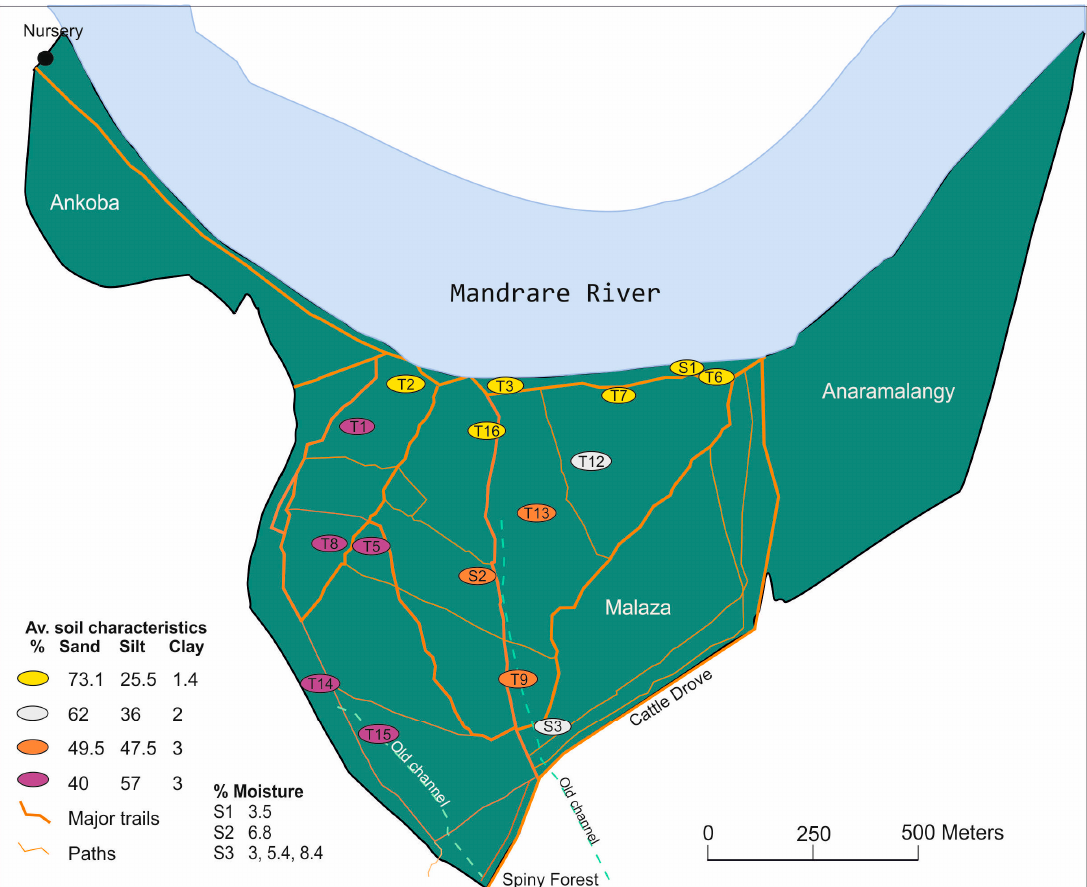
Figure 10. Soil sampling sites: The T samples are from the 2014 transects and the S1–S3 sites included soil moisture measurements.